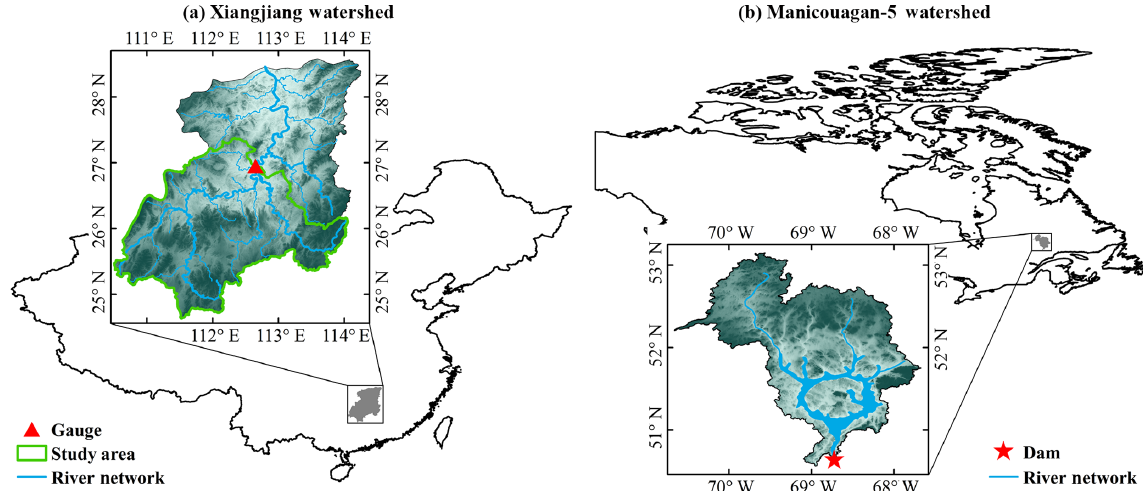
Figure 1. Locations of the (a) Xiangjiang and (b) Manicouagan-5 watersheds. (The study area in the Xiangjiang watershed is one of its sub-basins, shown here as the green